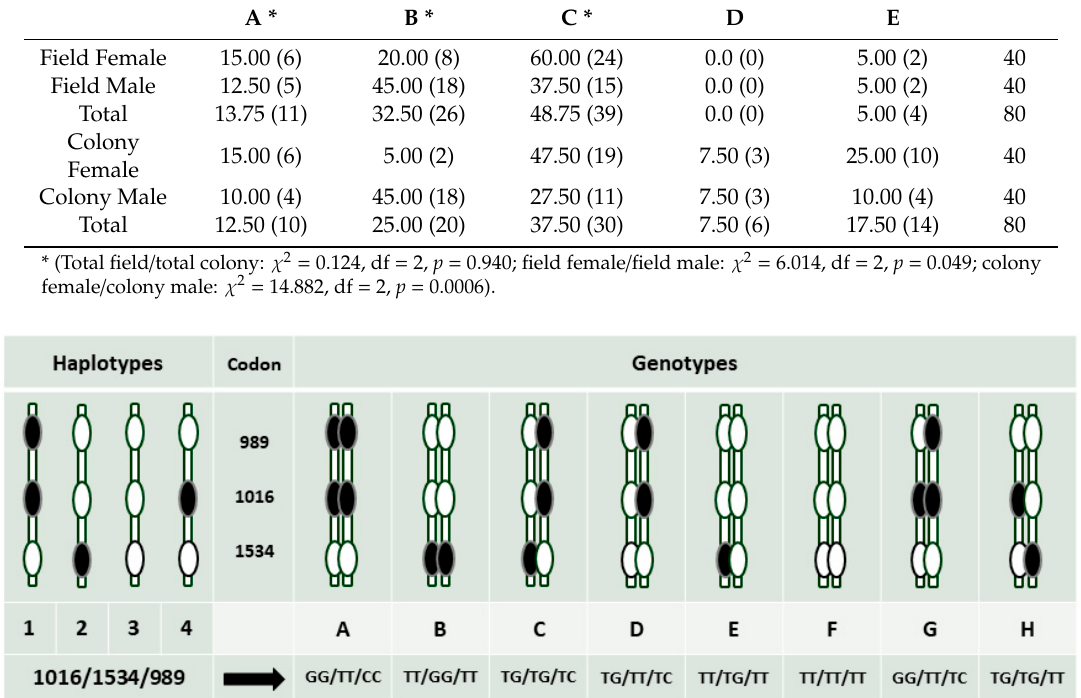
Table 4. Comparison of Vssc genotypes found in field (Shah Alam, 2016) and colony (B3F3 IMR) samples of Aedes aegypti (order of mutation sites 1016/1534/989) at the time of initial Wolbachia releases.